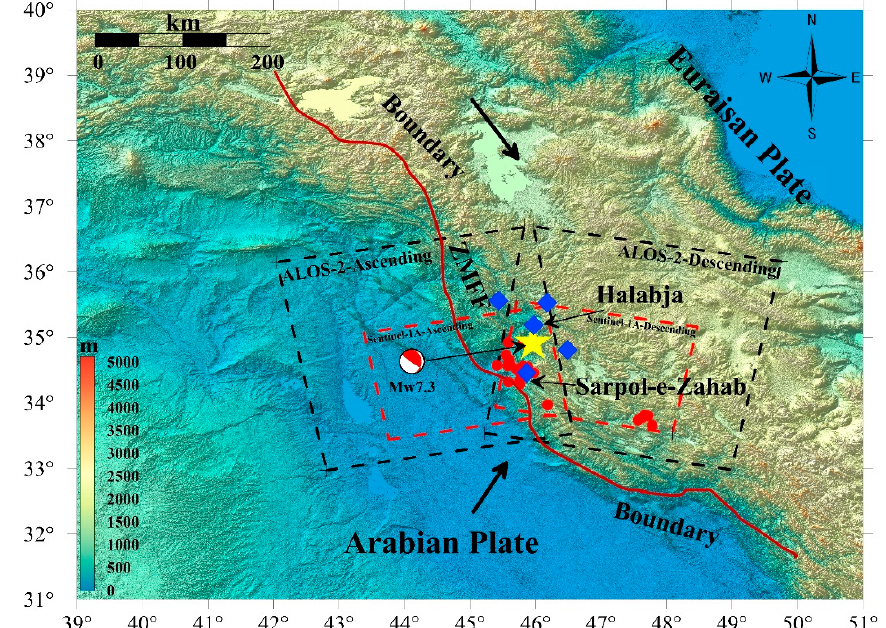
Figure 1. Shaded relief map of study area and image coverage. The yellow star indicates the epicenter of the mainshock (Mw 7.3). The red dots show the aftershocks with magnitude higher than Mw4.0 before 17 November 2017. The blue solid squares indicate the five cities with intensity reaching up to VI or higher. The black and red rectangles mark the coverage of SAR images. The dark red line represents the boundary between the Iraq and Iran.